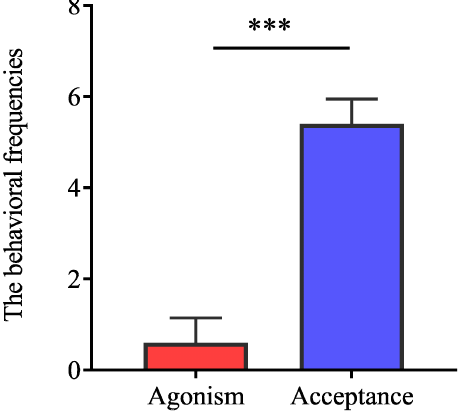
Figure 1. The frequencies of agonism and acceptance between the interspecific partners in the termites R. chinensis and R. flaviceps . The frequencies of acceptance are significantly higher than those of agonism between the interspecific partners ( t = − 8.35, df = 8, p < 0.0001). *** indicates p < 0.001.